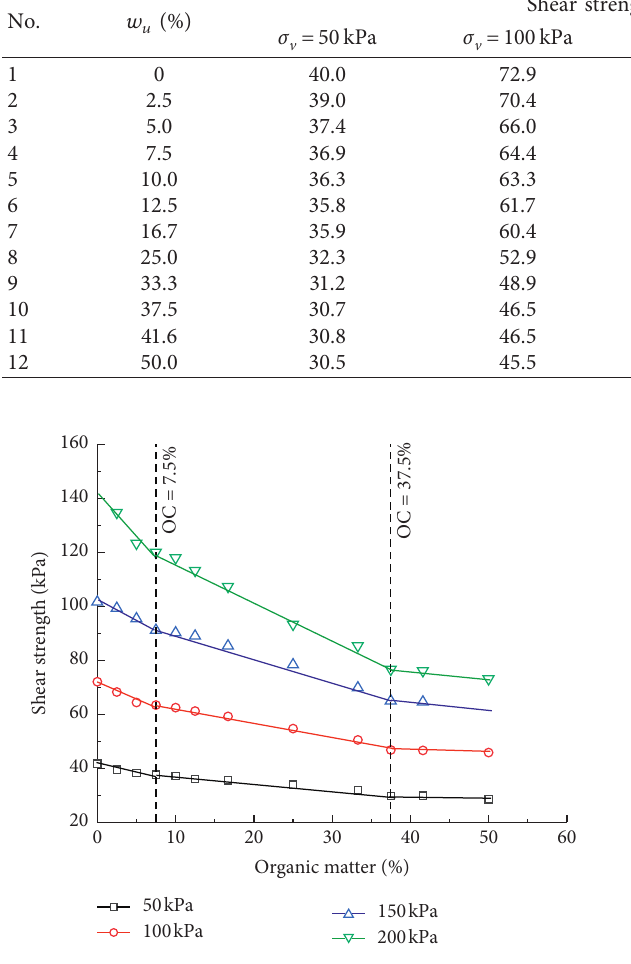
Figure 9: Relationship between organic matter content and shear strength under different vertical